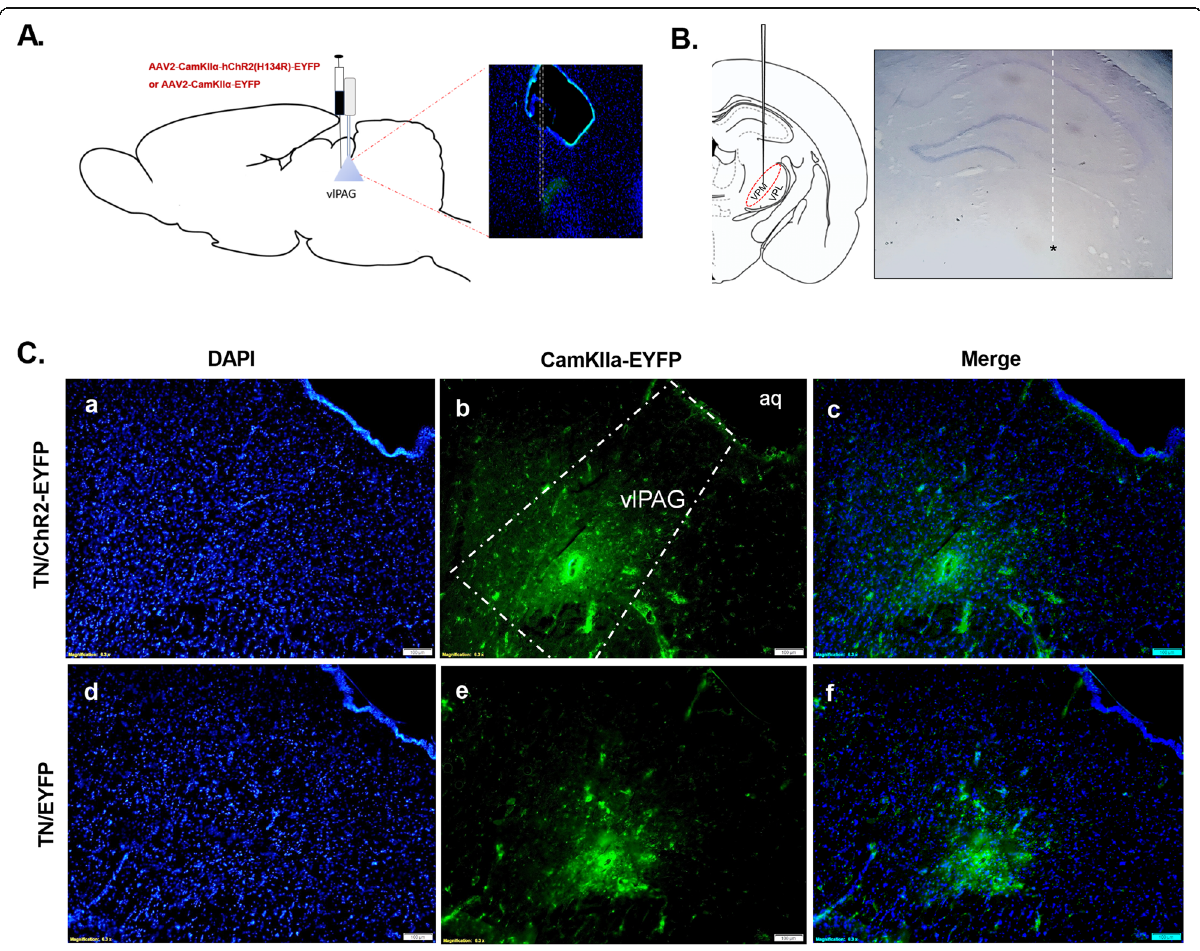
Fig. 2 Expression of viral vector in vlPAG. a Schematic and immunofluorescent diagram showing the location of virus injection and optic stimulation in vlPAG. b Schematic and cresyl violet stained diagram showing the location of electrode in VPM thalamus. c Immunofluorescence reveals the optogenetic viral expression in the vlPAG of TN/ChR2(above) and TN/EYFP animals (below); DAPI ( a, d ), EYFP ( b, e ), Merge ( c, f ). Scale bar=100 μ m in all